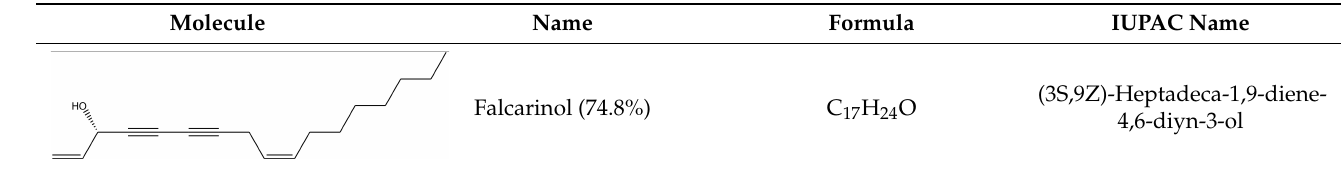
Table 2. Falcarinol structure and information.